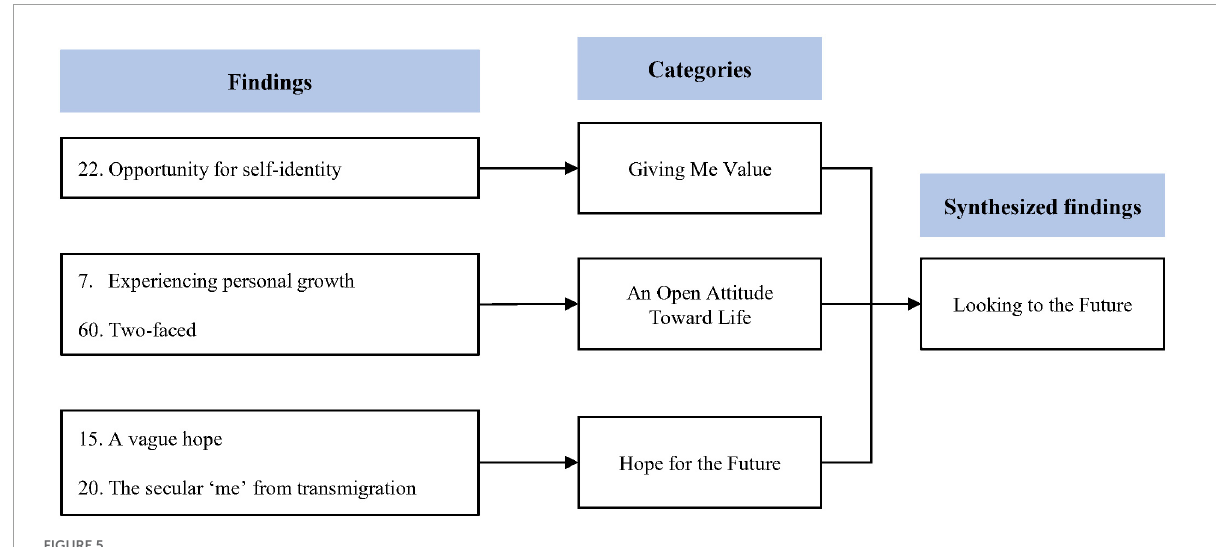
FIGURE5 Synthesized finding 4: Looking to the